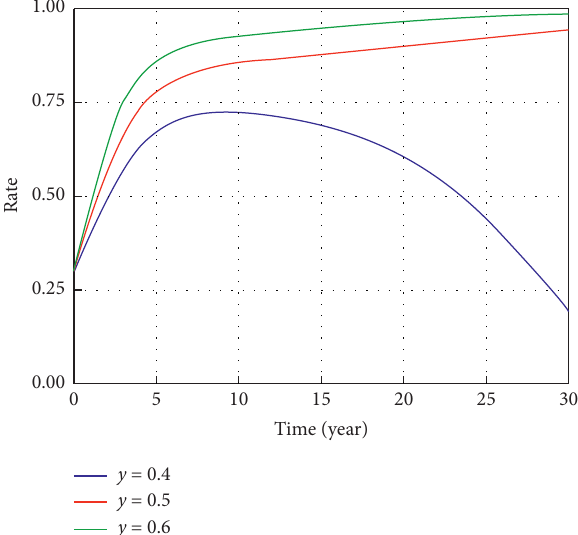
Figure 9: Simulation results under dynamic incentive